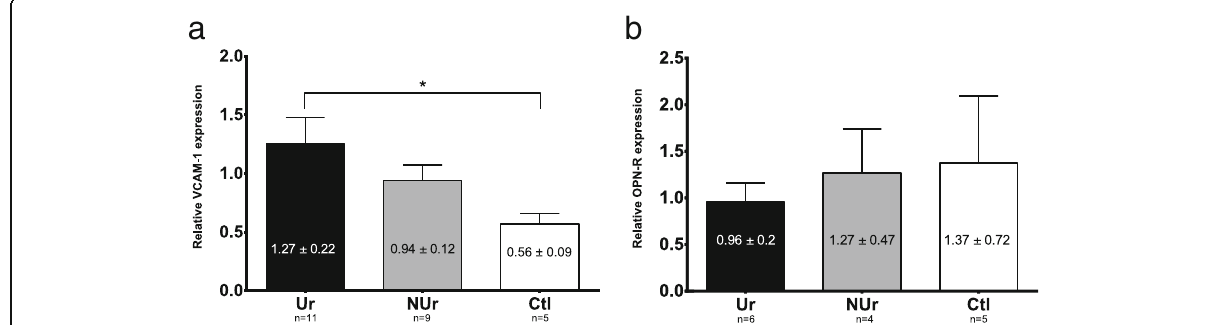
Fig. 6 VCAM-1 ( a ) and OPN-R ( b ) aortic protein expression. The protein expression was normalized for each animal by GAPDH protein